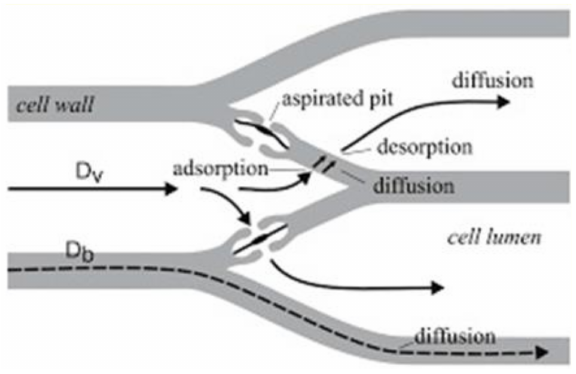
Figure 1. Water diffusion in wood